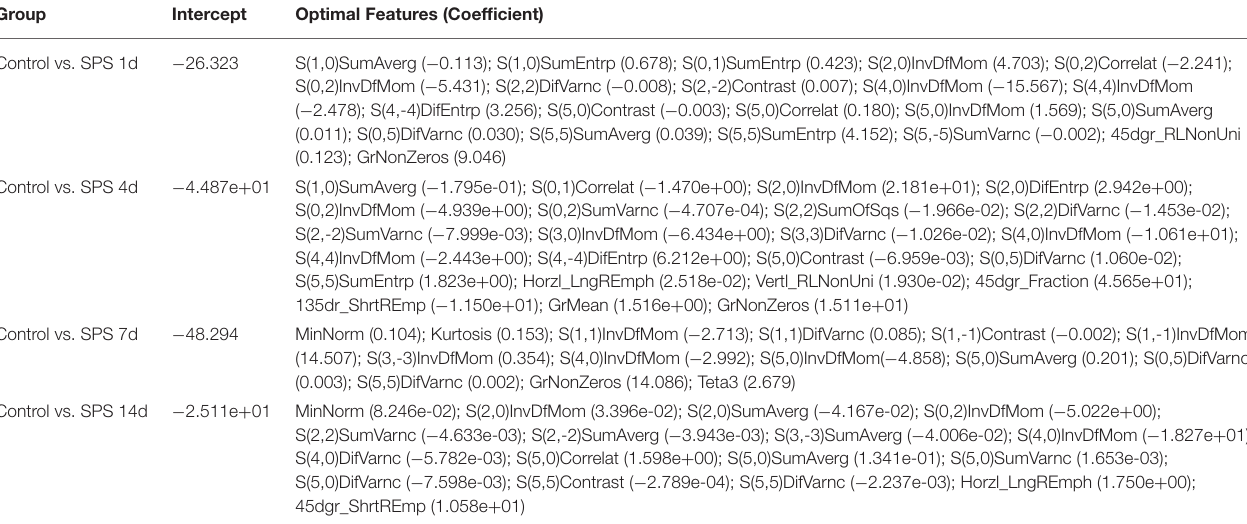
TABLE 2 | Optimal mPFC features after dimensionality reduction between the control and each SPS group via LASSO regression.